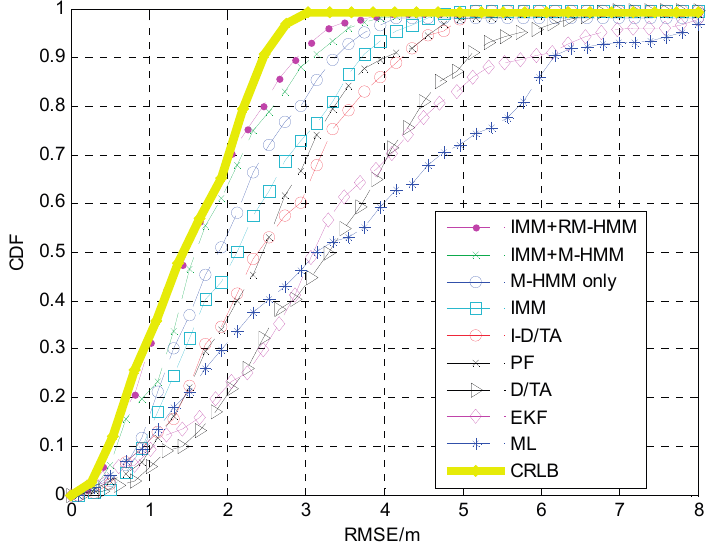
Figure 19. CDF analysis of various